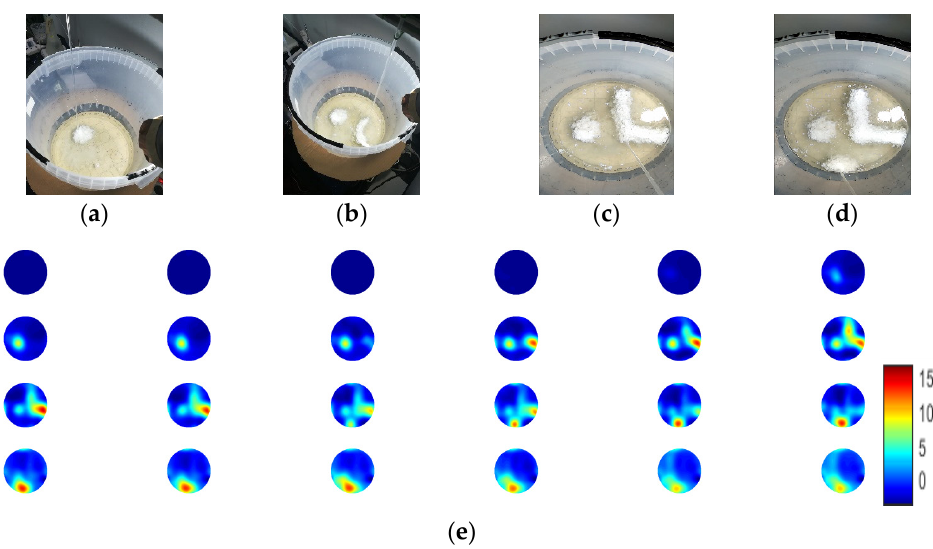
Figure 9. ( a – d ) Photos of the experiment and reconstructions. ( e ) Reconstruction with the specific capture time.